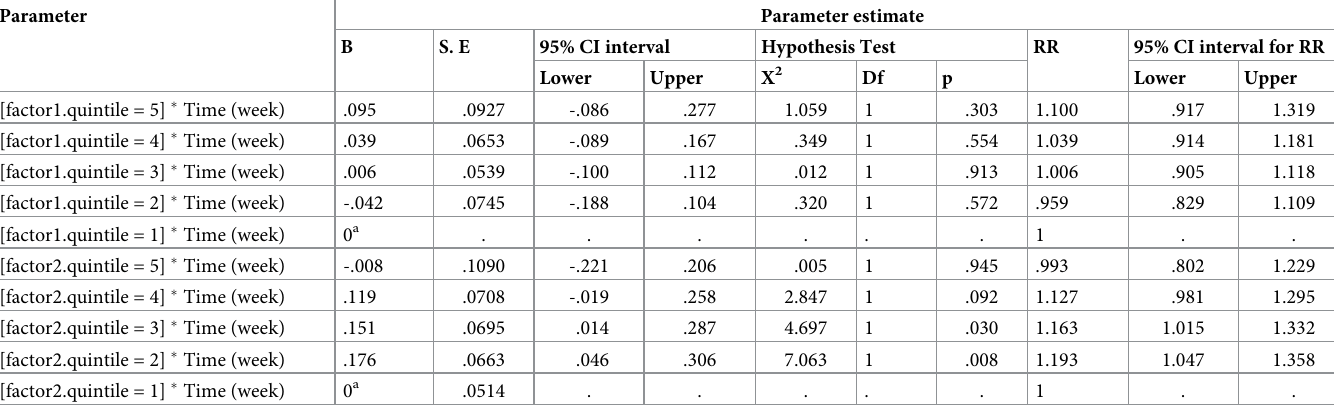
Table 3. Parameter estimates of model.